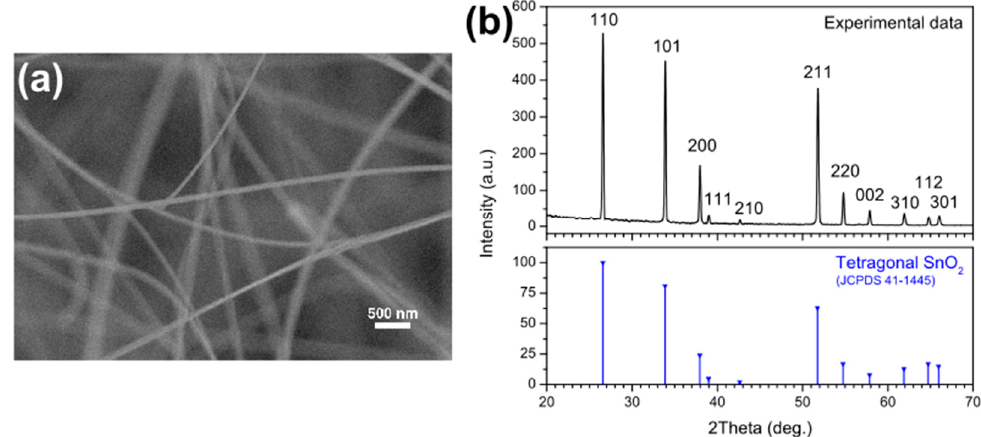
Figure 1. ( a ) SEM image and ( b ) XRD pattern of the SnO 2 nanowires.